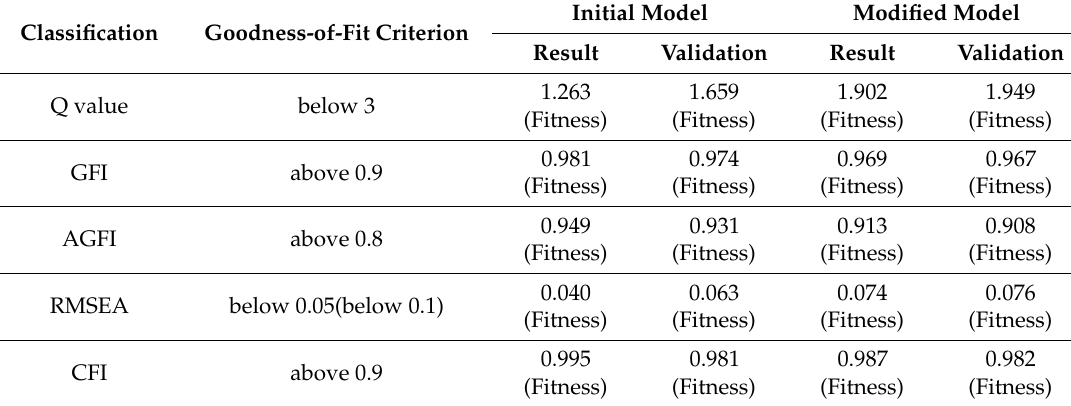
Figure 5. Developed path model for effluent T–N concentration. ( a ) Initial path model; ( b ) modified path model. Table 7. Fitness results of the developed path models for effluent T–P concentration.